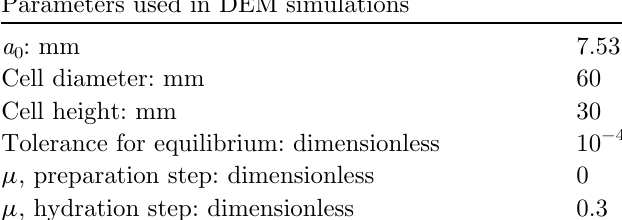
Fig. 5. Pictures of samples following hydration: left, SP1 and right,